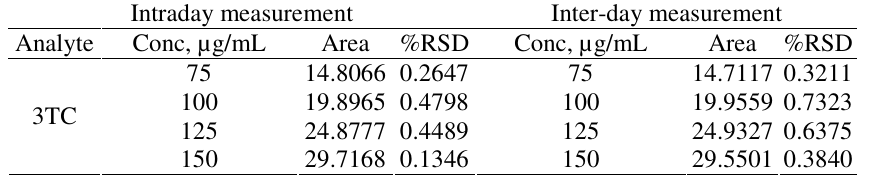
Table 4. Precision data for the proposed method.